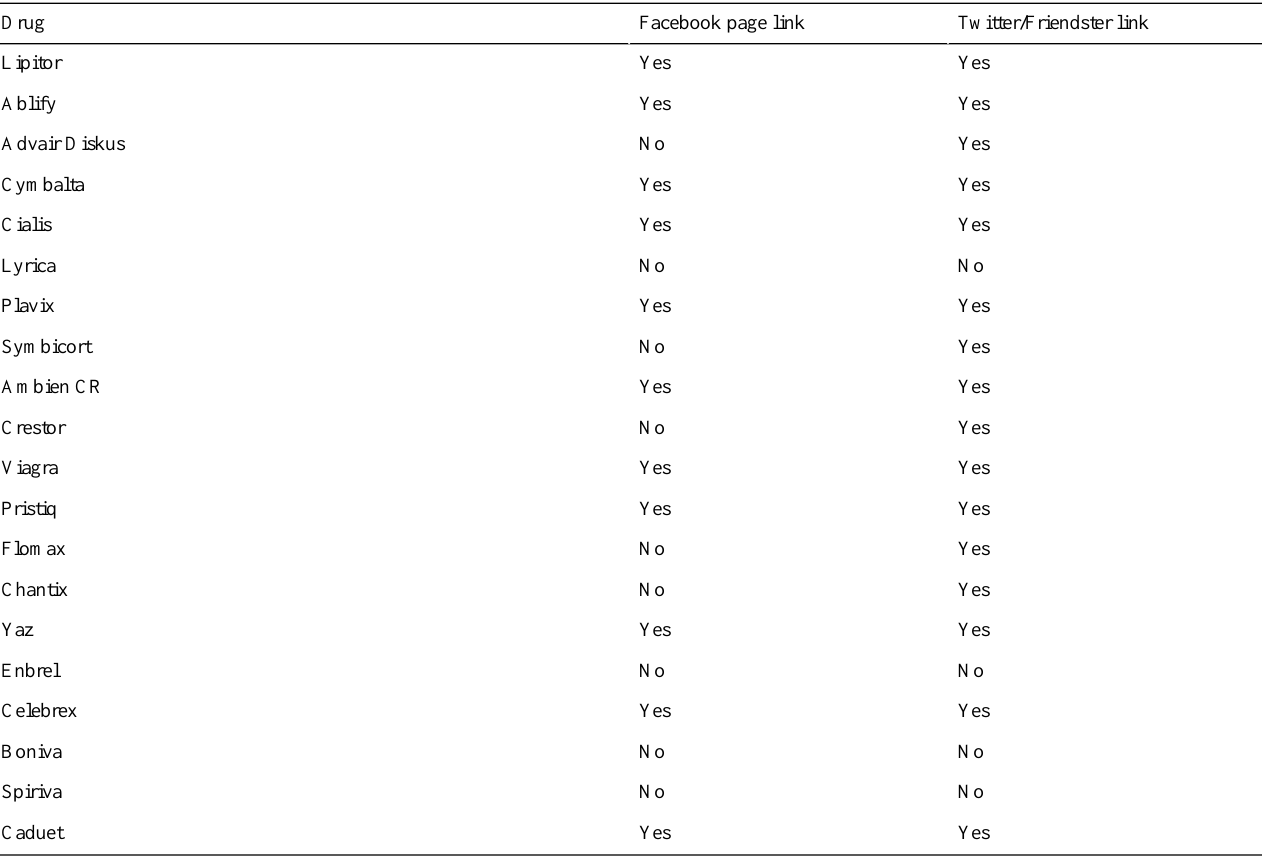
Table 3. Top 20 drugs by global sales and eDTCA 2.0 a link to illegal online drug sellers